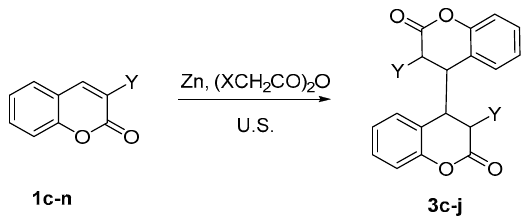
Table 3. Homodimerization of 3-substituted coumarins 1c – n under ultrasound reaction conditions. Coumarin